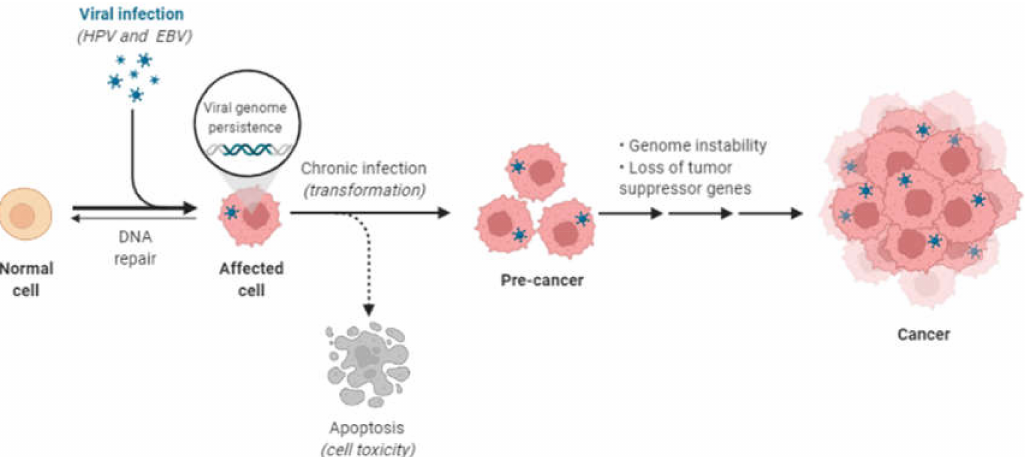
Figure 3. The process of carcinogenesis as a result of viral integration into the host genome (Image created by biorender.com, accessed on 23 January